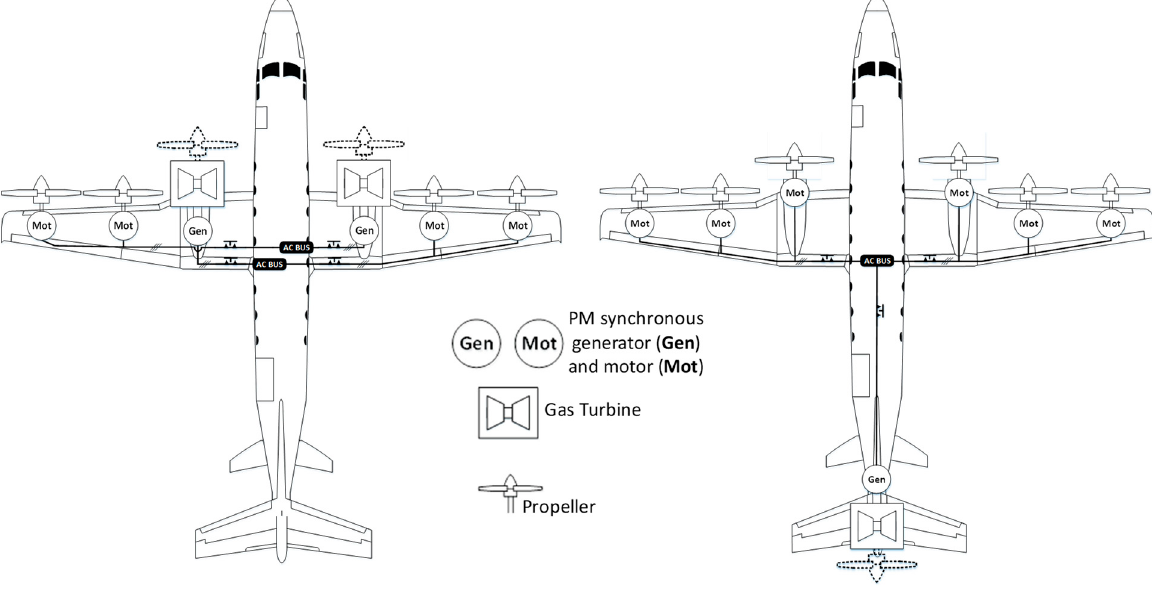
Figure 2. Two example of architectures (here with six propellers) with direct AC coupling between generators and motors. generators and